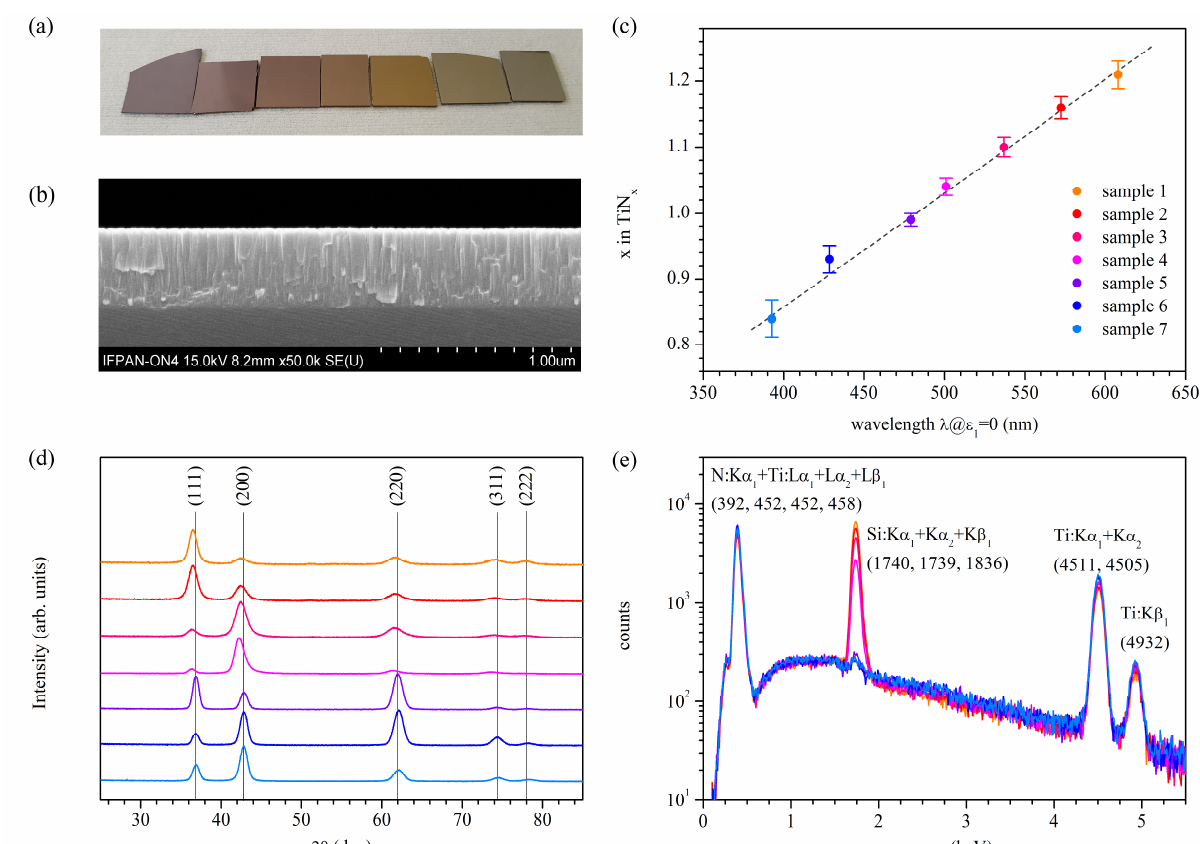
Figure 1. ( a ) Picture of one of the three series of samples; ( b ) SEM image of a cross-section of the stoichiometric sample; ( c ) composition of TiN x samples determined from SIMS experiment as a function of the wavelength, at which the real part of the dielectric function crosses zero; ( d ) GIXRD patterns proving that the crystal structure Fm3(cid:3364)m is preserved despite changes in composition; ( e ) EDS spectra proving that there are no other elements than Ti and N; the Si line comes from the substrate.